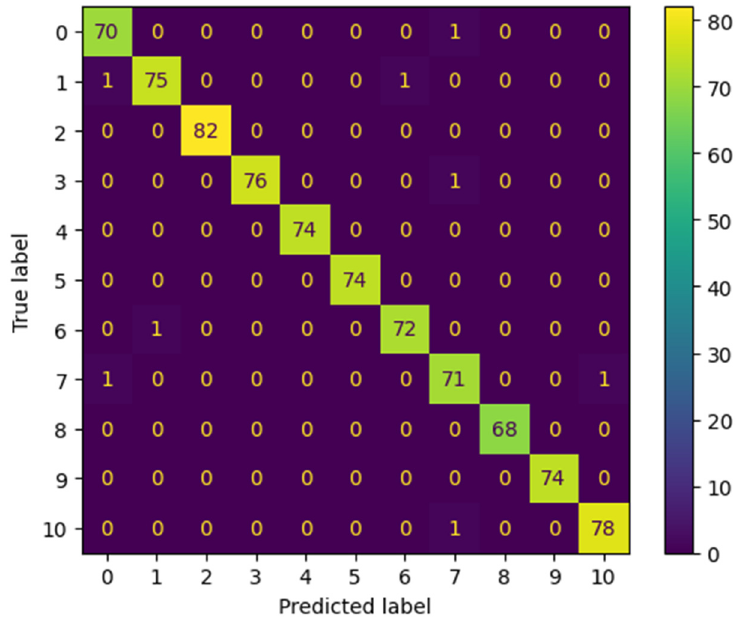
Figure 22. Confusion matrix of ResNet50 performance.